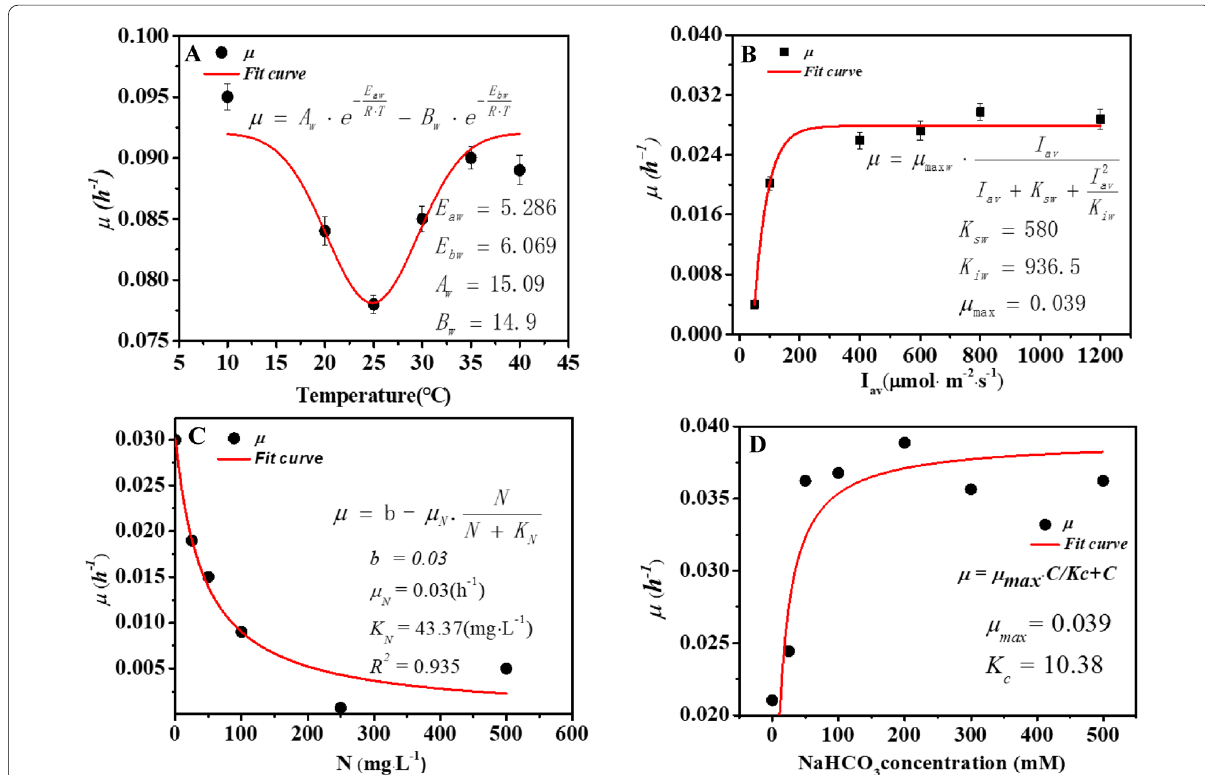
Fig. 2 β-Carotene accumulation rate of D. salina under different culture conditions. A The relationship of temperature and β-carotene accumulation rate. B The relationship of light intensity and β-carotene accumulation rate. C The relationship of nitrogen concentration and β-carotene accumulation rate. D The relationship of carbon concentration and β-carotene accumulation